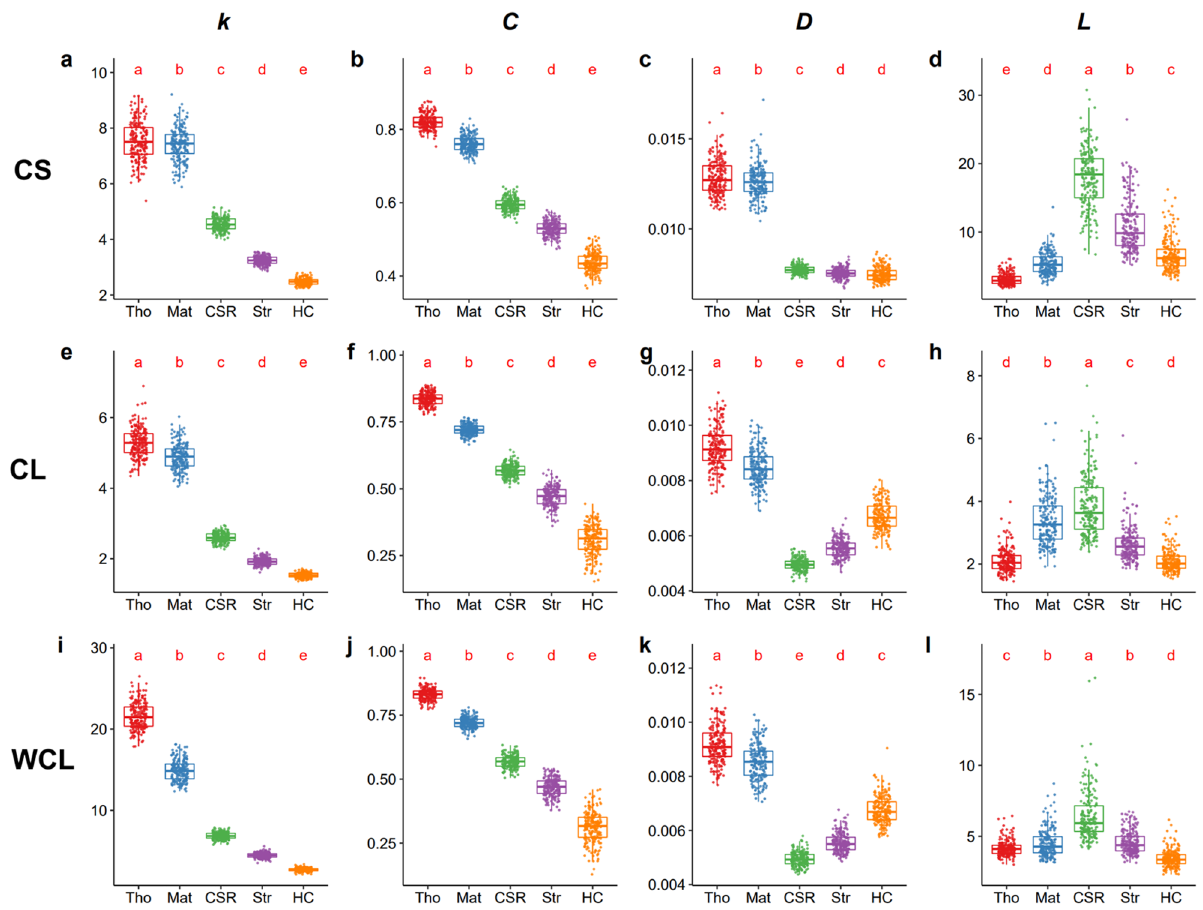
Figure 3. Basic characteristics of three types of networks (with individual trees as nodes) based on five spatial null models ( CSR complete spatial randomness, Mat Matérn process, Tho Thomas process, HC Gibbs hard core process, Str Strauss process). Values of each metric (the average node degree k, the clustering coefficient C , the density D , and the average path length L ) are generated by 199 Monte-Carlo simulations. Differences among five models were examined by ANOVA, followed by Tukey multiple comparisons tests (for more details, see Supplementary Table S2). In WCL, the weighted average node degree k was calculated, while values of C , D , and L are consistent with that of CL because edge weights are not used when calculating these